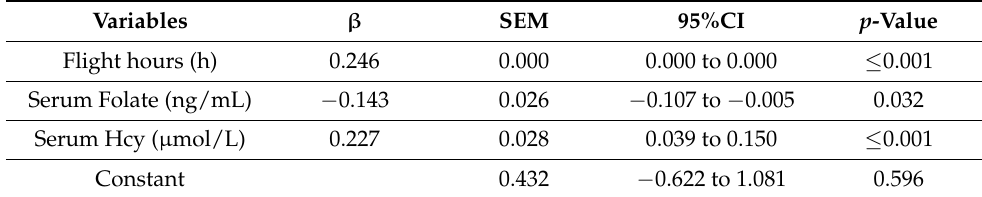
Table 9. Hearing loss adjusted by age in a multiple regression